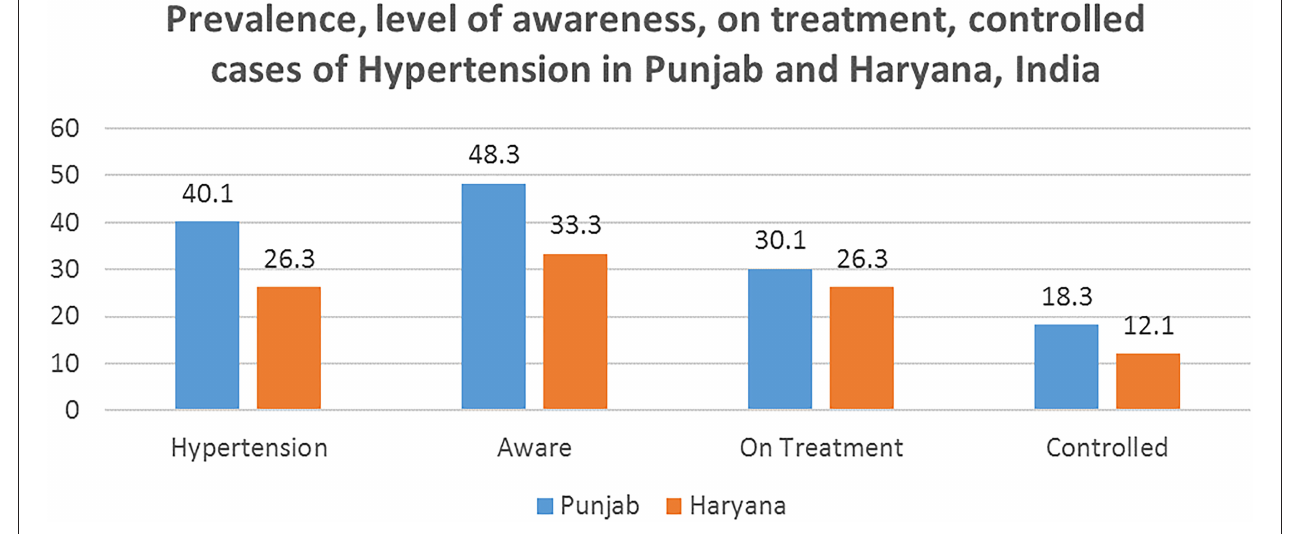
FIGURE 1 | Extent of awareness, on treatment, controlled cases of hypertension in Punjab and Haryana, India.